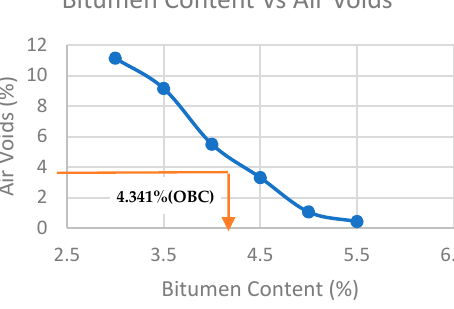
Figure 6. Volumetric properties of HMA samples. As per the National Asphalt Pavement Association, OBC was determined against 4% AV, which turned out to be 4.341%. All the other volumetric properties were then noted against 4% AV. Table 7 summarizes the volumetric properties of HMA at OBC.